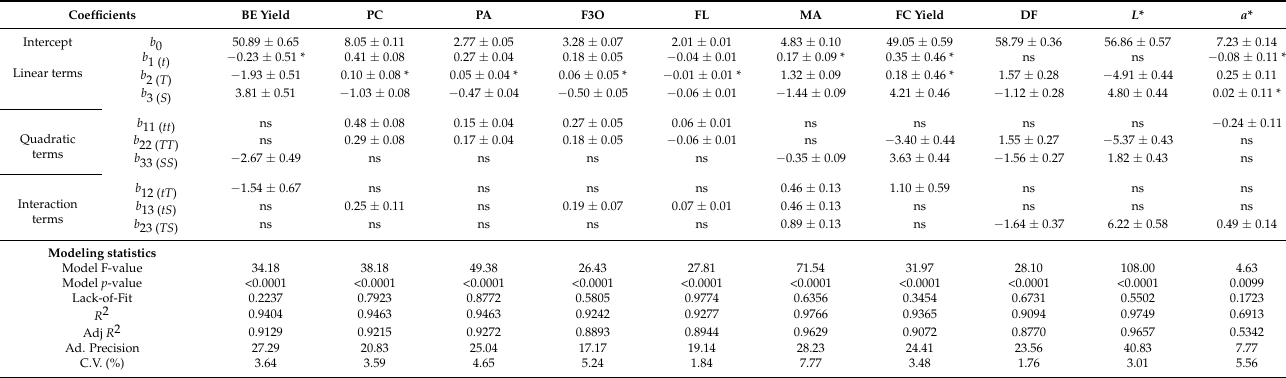
Table 3. Parametric values estimated with Equation (1) and statistical data of the models’ fitting procedure for BEs and their bioactive constituents and for FCs and their dietary fiber content and color